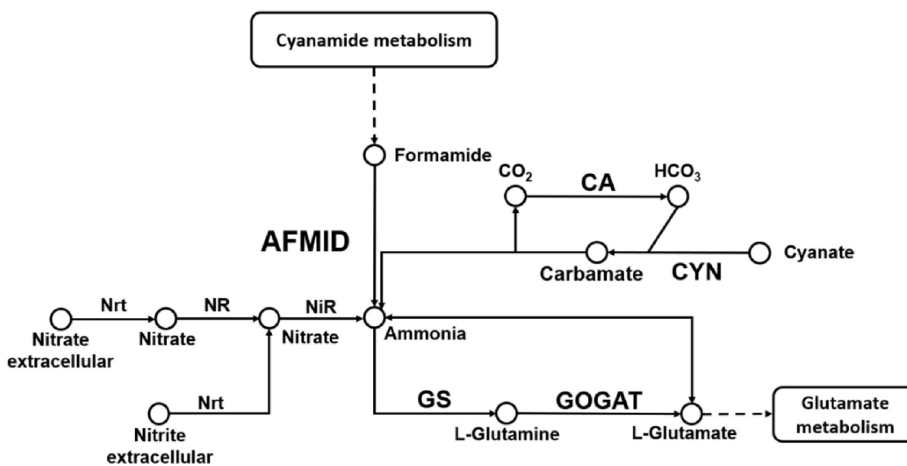
Fig 8. A schematic representation of the N metabolism pathway emphasizing the differentially expressed genes in potato. NRT, nitrate transporter; NR, nitrate reductase; NiR, nitrite reductase; GS, glutamine synthetase; GOGAT, glutamate synthase; AFMID, formamidase; CA, carbonic anhydrase; CYN, cyanate hydratase; GDH, glutamate synthase.